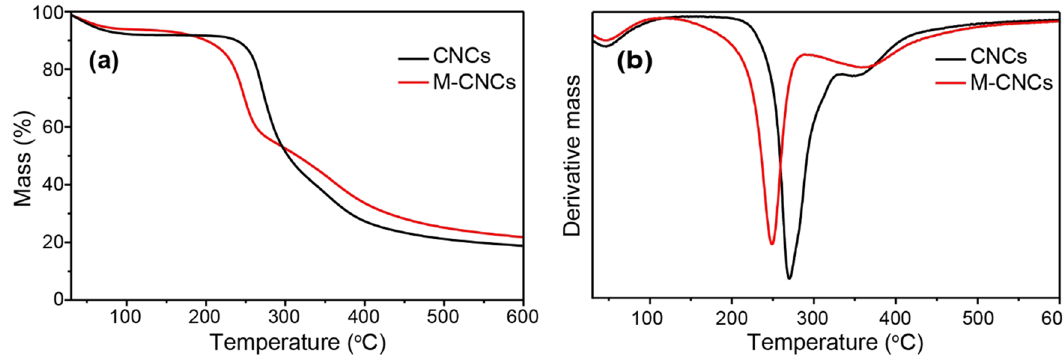
Figure 4. ( a ) TGA curves and ( b ) DTG curves of CNCs and